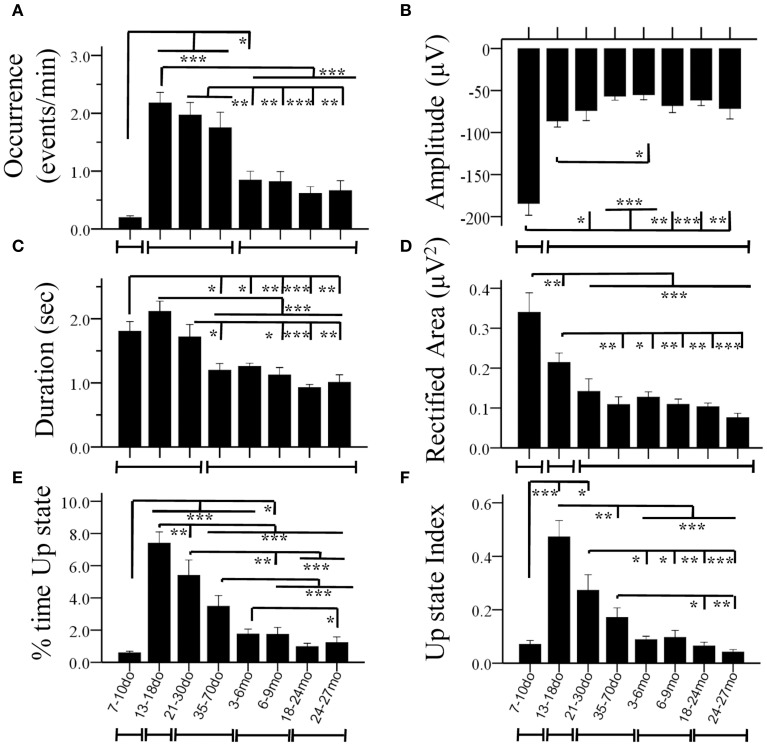
Age-dependent changes of Up state parameters in the mouse S1BF cortex. Bar plots illustrate mean values for occurrence (A), amplitude (B), duration (C), rectified area (D), percent (%) time spent in the Up state (E) and Up state index (F), for the eight age groups. The lines below the X axis indicate the developmental periods with similar values (for each specific parameter) that are statistically different from preceding and following developmental stages (*p < 0.05, **p < 0.01, ***p < 0.001).